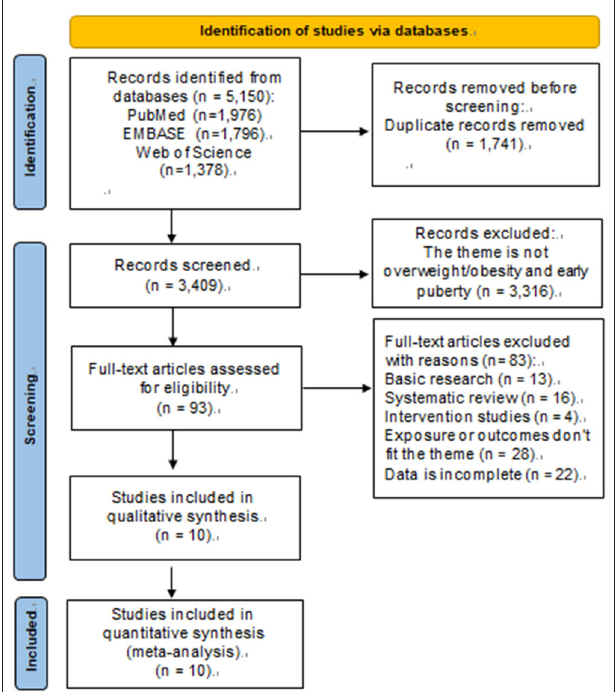
FIGURE 1 | PRISMA flow